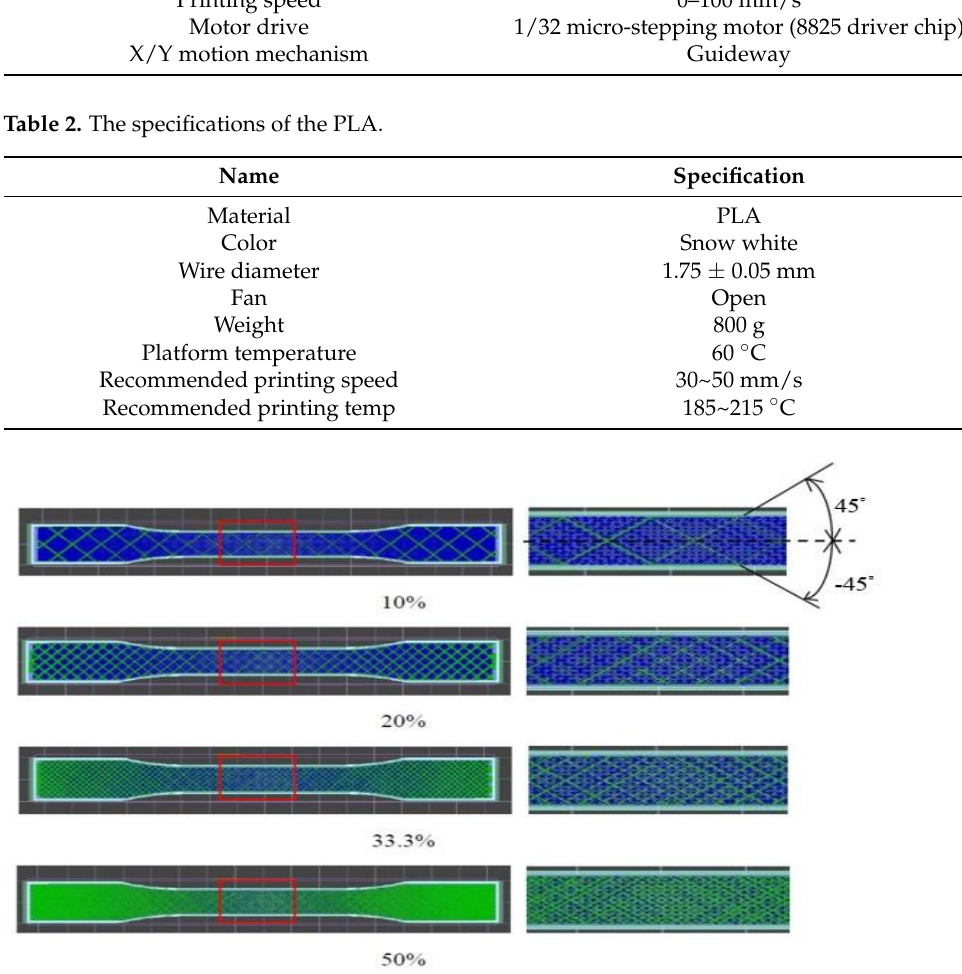
Figure 1. A schematic view of each filling percentage.